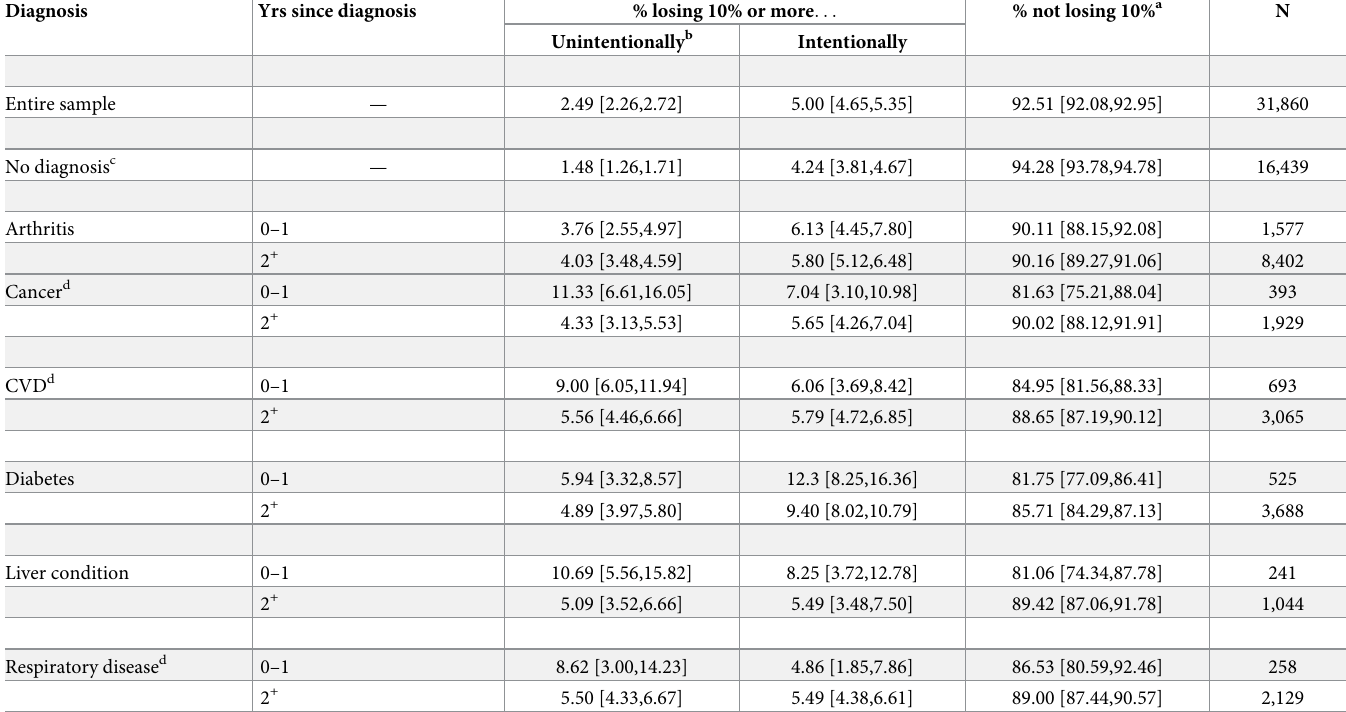
Table 3. Weight loss intentionality among individuals losing at least 10% of their body weight in the last year. a Adults 30+, NHANES 1999–2014. 95% confidence interval in brackets.